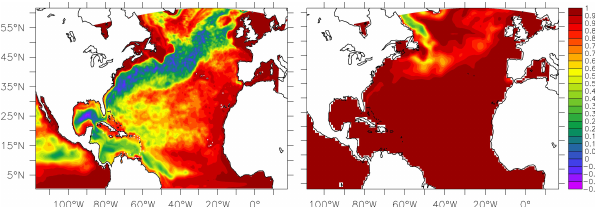
Fig. 2. Correlations between SSH variability in experiments A025 and B025 (left), and between SSH variability in A100 and B100 (right). The correlation values are obtained from 5-day